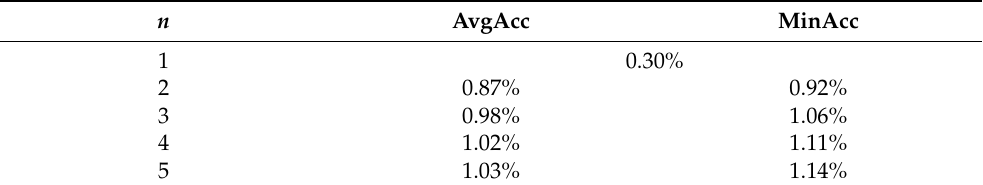
Table 1. RMSE of model soups val and test accuracies for each number of models synthesized. The merged models have the same hyperparameters but different training and validation